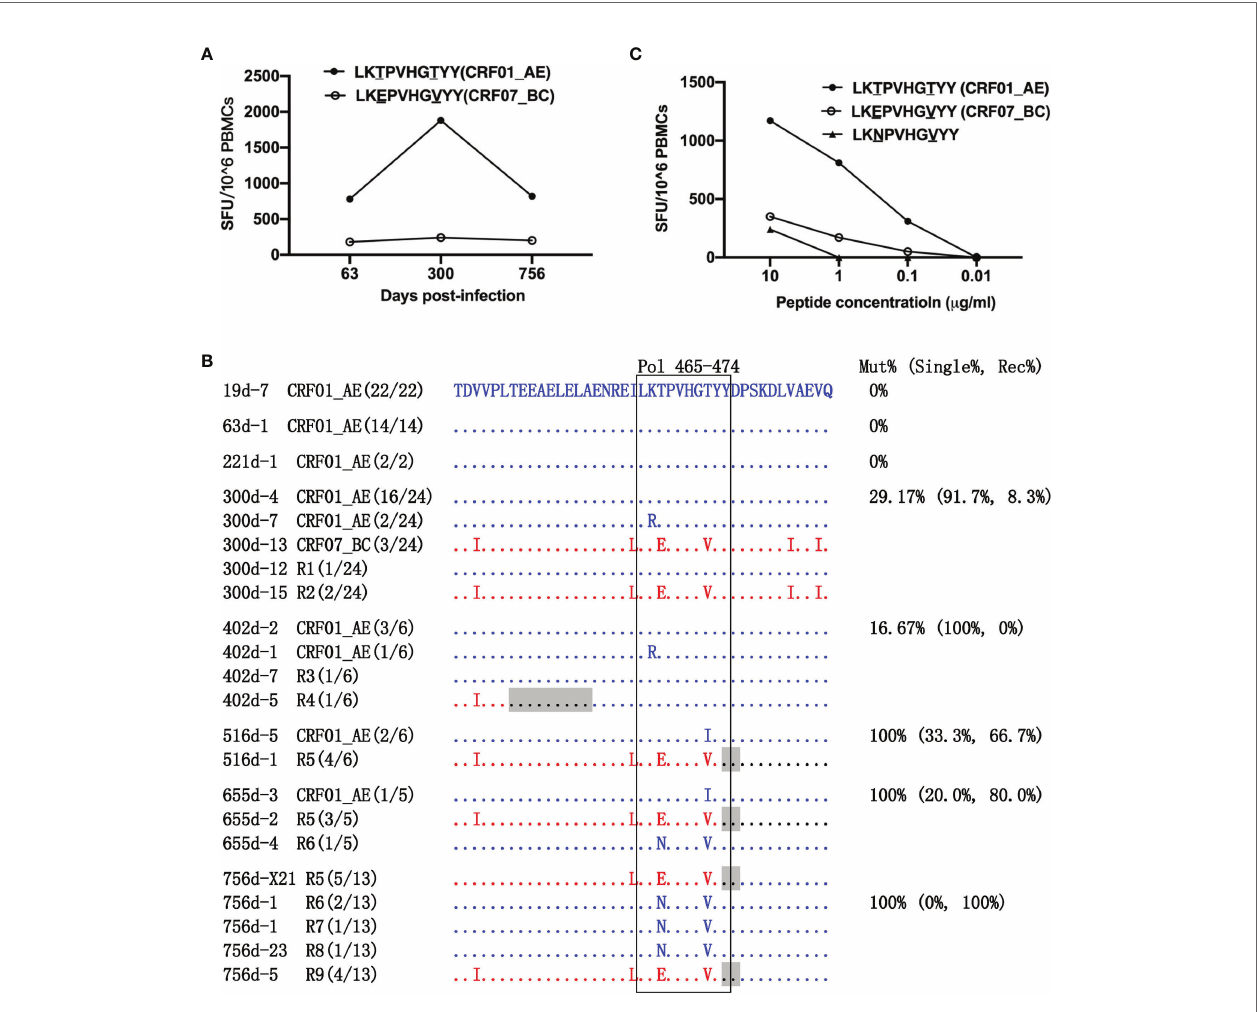
FIGURE 3 | Escape from LY10 epitope-speci fi c T-cell responses. (A) T-cell responses targeting the CRF01_AE-LY10 and CRF07_BC-LY10 epitopes were detected at 63, 300, and 756 days post-infection (dpi) by ELIspot. The different amino acids between the two epitopes are underlined. (B) The amino acid alignment of partial regions of the Pol protein covering the LY10 epitope and its fl anking regions at different time points. Sequences derived from the CRF01_AE strains are highlighted in blue. Sequences derived from the CRF07_BC strains are highlighted in red. The recombination breakpoints are shaded gray. The amino acids of the LY10 epitope are boxed in black. The number in parentheses indicates the number of clones with the reported sequence. The percentages of sequences with epitope mutation (Mut%) and the percentage of single (Single%) or recombinant sequences (Rec%) are listed. (C) Responses to various variants within the LY10 epitope were detected using peripheral blood mononuclear cells (PBMCs) at 756